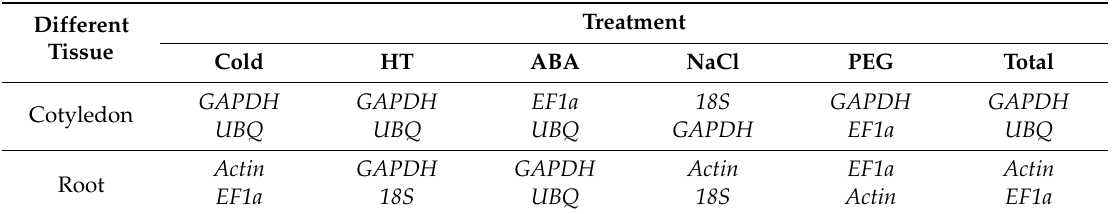
treatment; NaCl: Sodium Chloride treatment; PEG: Polyethylene Glycol treatment.